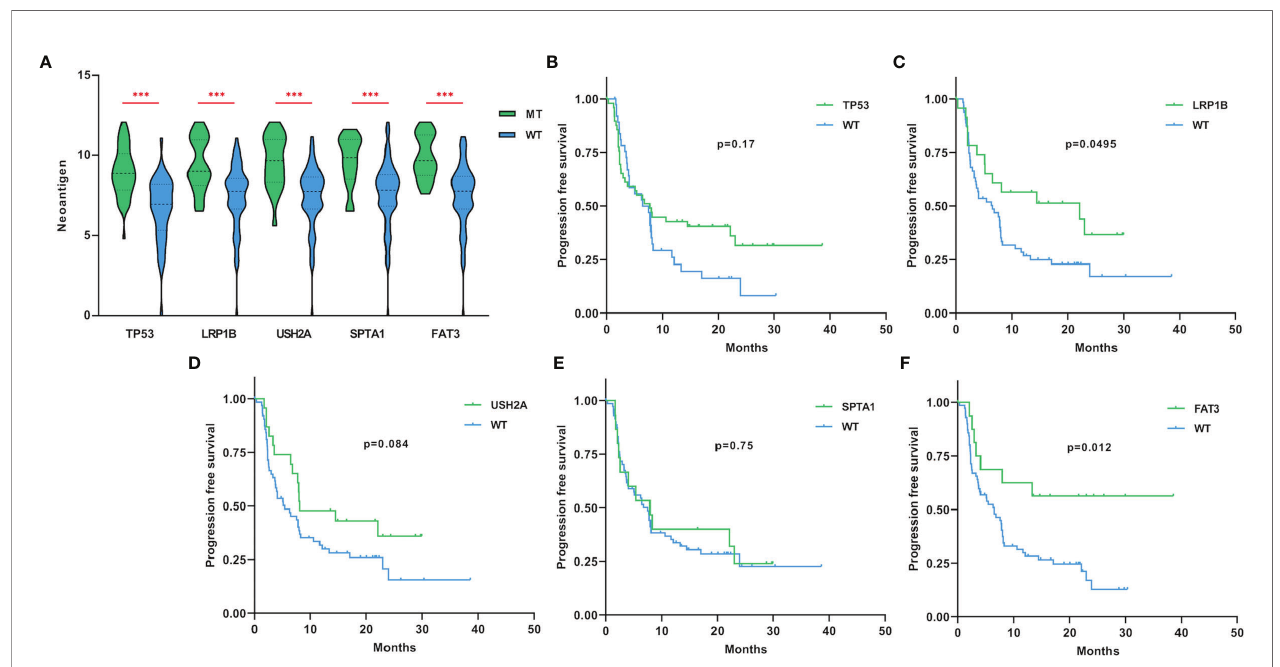
FIGURE 3 | The associations of gene mutations with neoantigen and immunotherapy PFS. (A) LUAD samples with TP53, LRP1B, USH2A, SPTA1 and FAT3 mutations had higher levels of neoantigen (adding one pseudo-count and log 2 transformation). (B – F) Compared with non-mutated LUAD samples, LUADs with LRP1B and FAT3 mutations had signi fi cantly longer PFS for immunotherapy. WT=wild-type. Statistical comparisons between different groups were made by Mann- Whitney test (A) , and survival curves were plotted using the Kaplan-Meier method and compared by the log-rank test (B – F) . ***p <